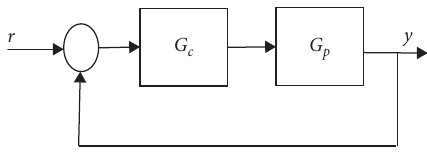
Figure 1: Model-based